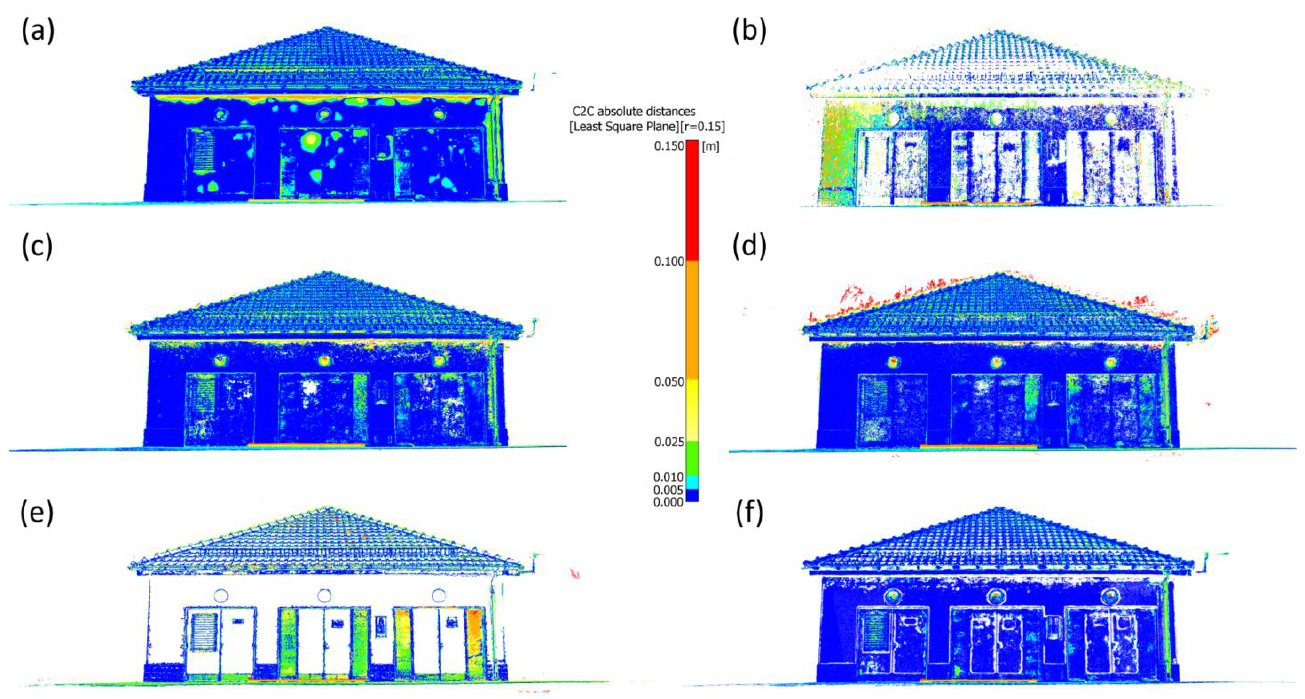
Figure A5. Comparison of TLS and image-based point clouds of elevation 3: ( a ) ContextCapture; ( b ) GRAPHOS; ( c ) Metashape; ( d ) PhotoScan; ( e ) Pix4DMapper; ( f ) RealityCapture.